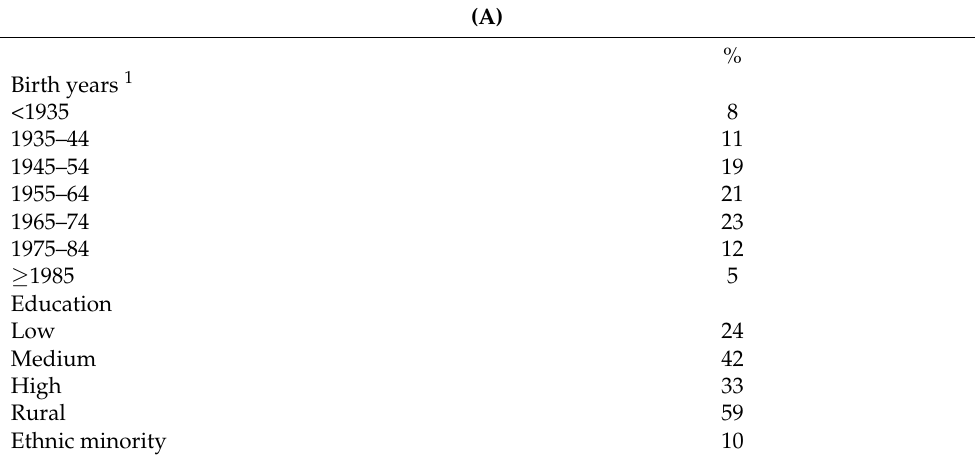
Table 1. ( A ) Time-invariant variables (N = 11,810); ( B ) Time-varying variables (N = 38,072 person- year